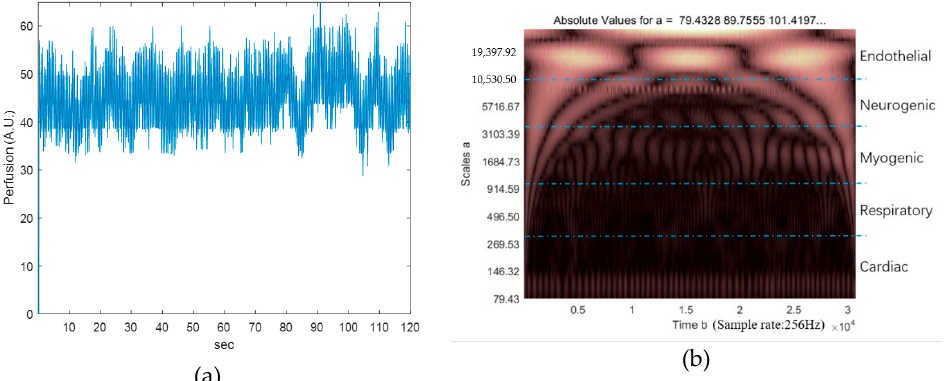
Figure 4. The skin blood flow measurement.